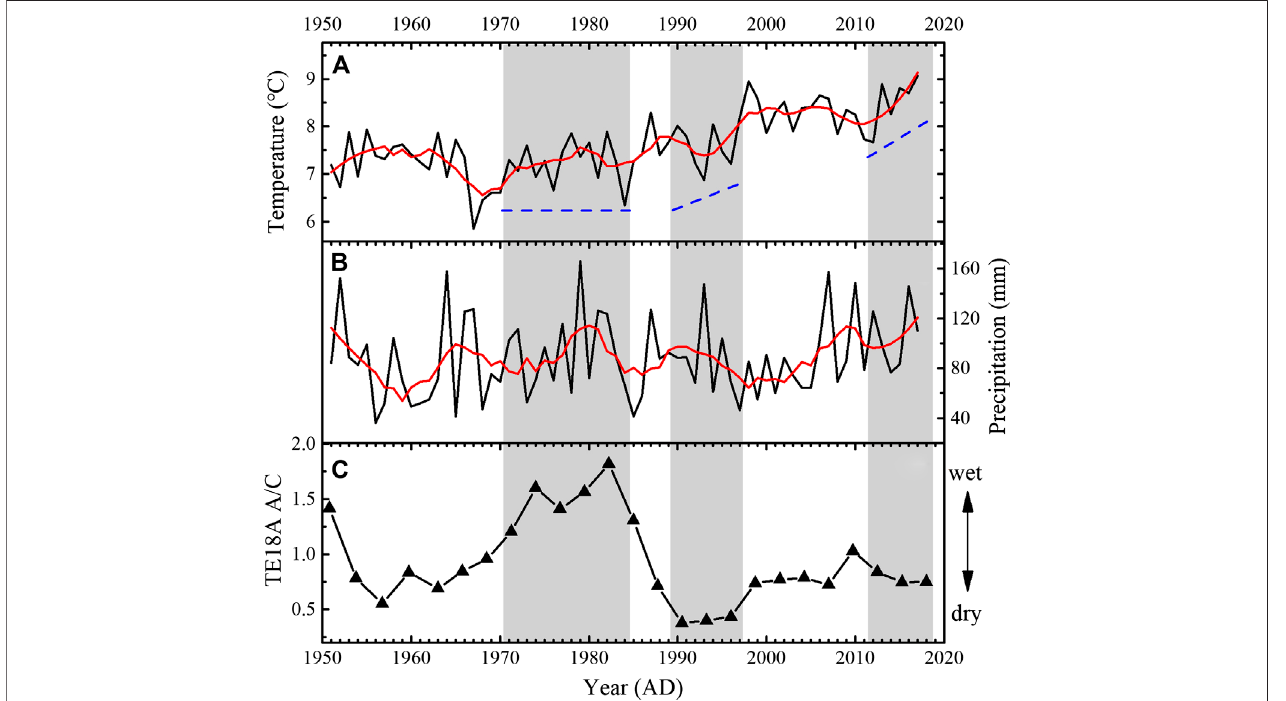
FIGURE 4 | Comparison of the A/C ratio with the meteorological information from the Jiuquan station during 1951 – 2017. (A) Mean annual temperature ( ° C). (B) Mean annual precipitation (mm). (C) Pollen A/C ratio from Tian ’ E Lake. The red curve is the result of 10-point smoothing. The blue dashed line indicates the trend of temperature. Some high precipitation periods are indicated by gray